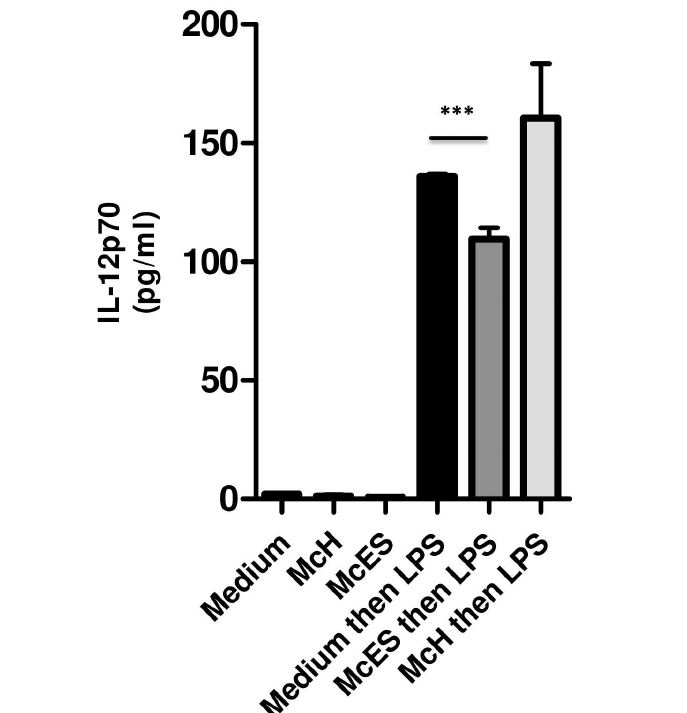
Fig 5. McES, but not McH impair TLR ligand-induced BMDC activation. BMDCs were generated in vitro from C57BL/6 mice bone marrow cells and stimulated in vitro with 5 μ g/ml of M . corti ES products (McES)